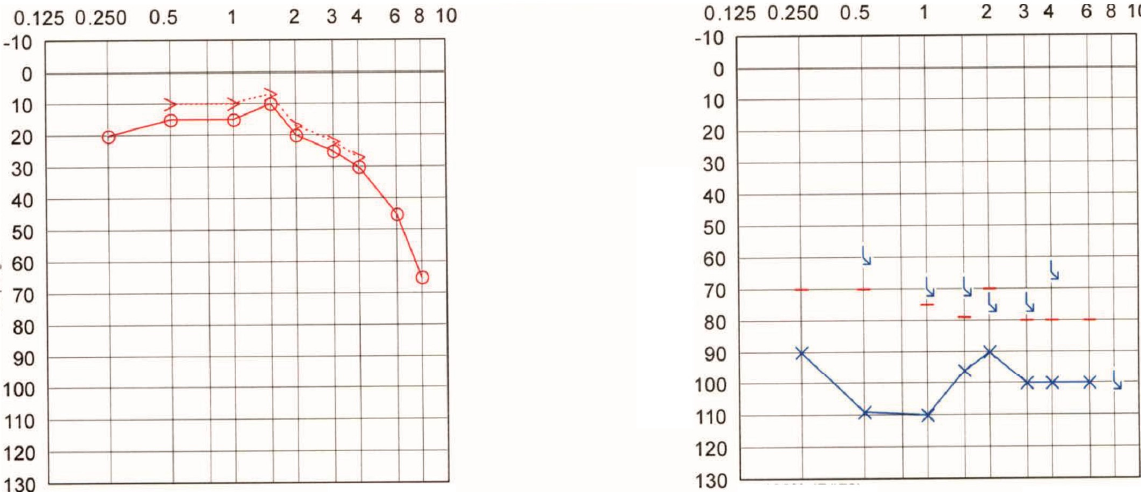
Figure 6. Pure tone audiogram of Patient #10 with left-sided Meni è re’s